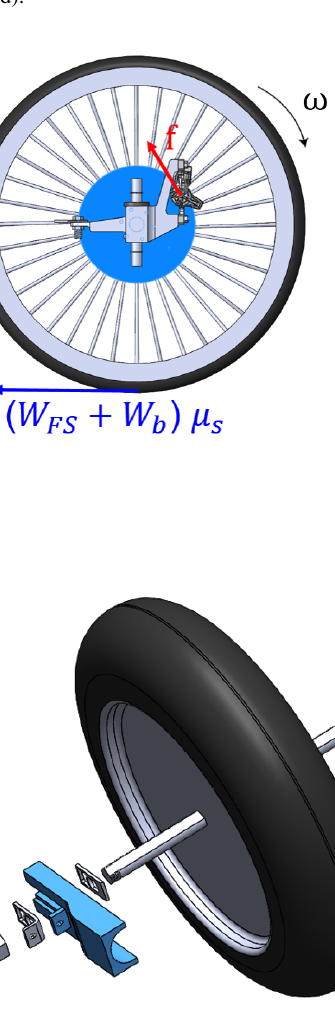
Figure 15. Exploded view of the rear wheel